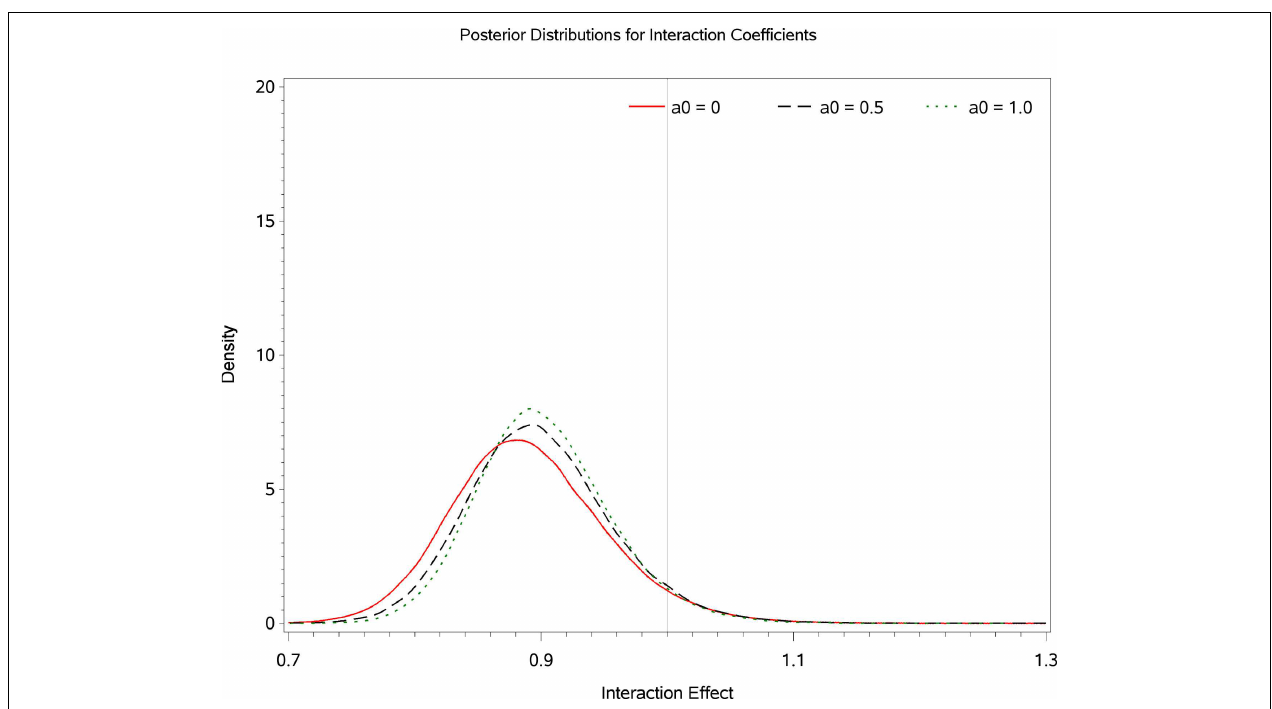
FIGURE 4 | Posterior distributions of the interaction parameter at values of a 0 = 0, 0.5, and